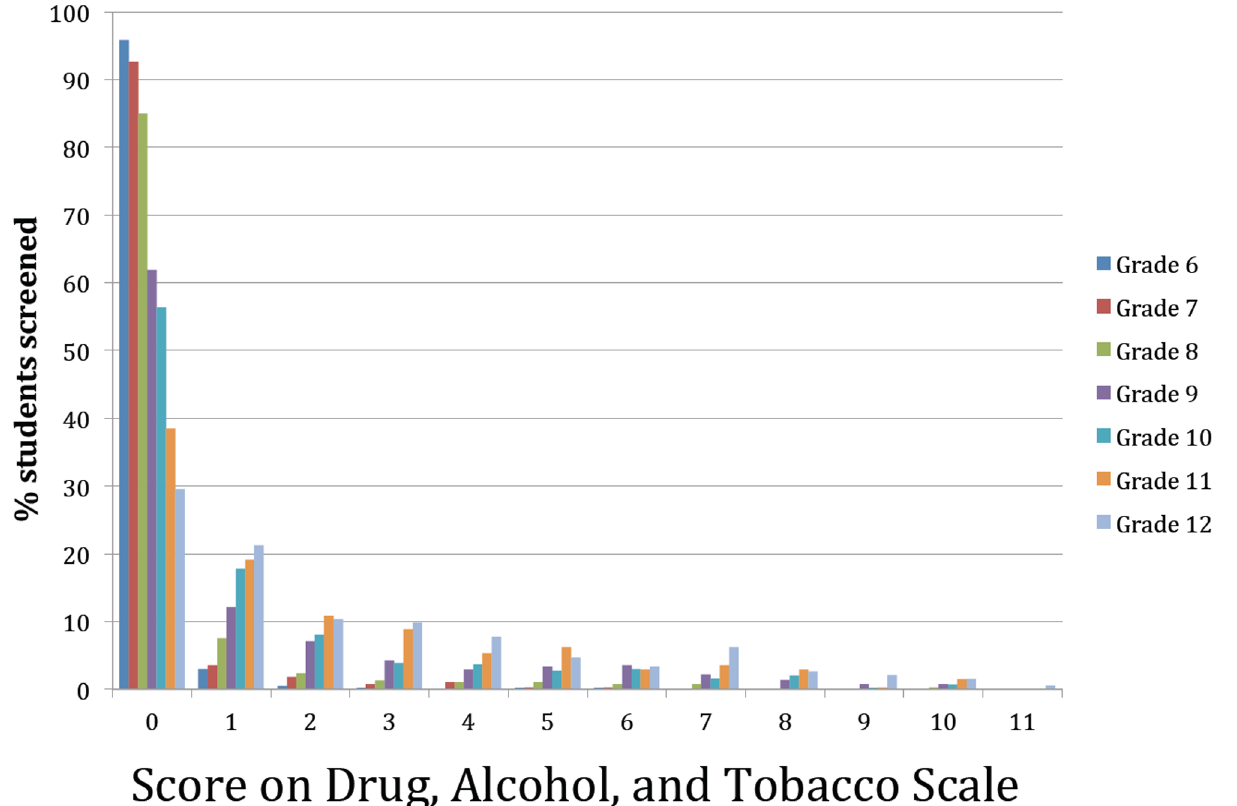
Fig 7. Distribution of drugs, alcohol, and tobacco scores at baseline. The distribution of scores for the use of drugs, alcohol, and tobacco is shown for all 7 Grades (average ages at start of study are 11.3 for Grade 6, 12.3 for Grade 7, 13.3 for Grade 8, 14.3 for Grade 9, 15.3 for Grade 10, 16.4 for Grade 11, and 17.4 for Grade 12). While these scores do not have diagnostic validity, we indicate the distribution of these scores. It can be seen that at all scores the distribution is that the oldest youth have more use of drugs, alcohol, and tobacco, and have been involved in more significant activities that may put them at risk. It is consistent with previous studies that less than 30% of youth in Grade 12 have not used drugs, alcohol, or tobacco in the previous 12-months, compared to more than 95% of those in Grade